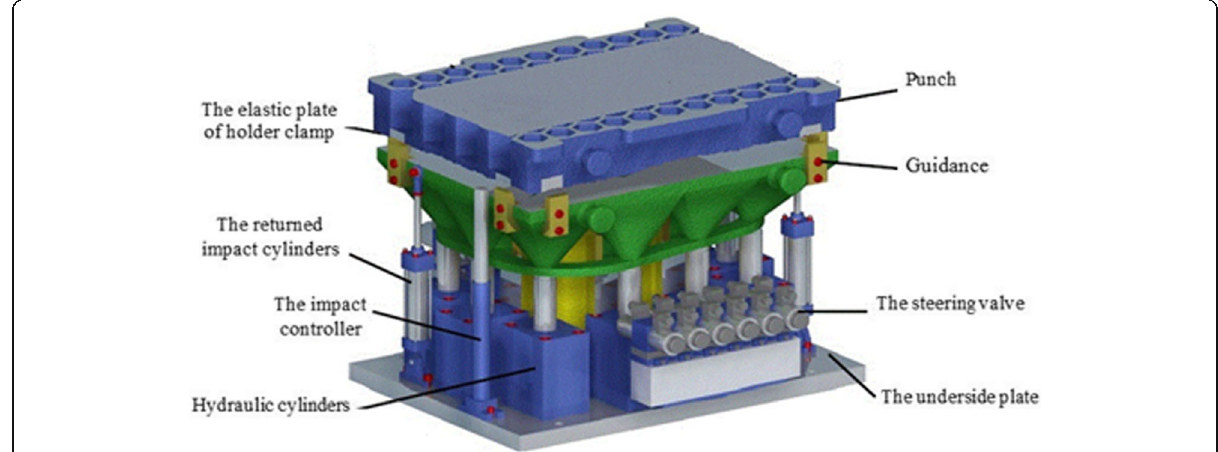
Fig. 10 Components of the airfoil deep drawing